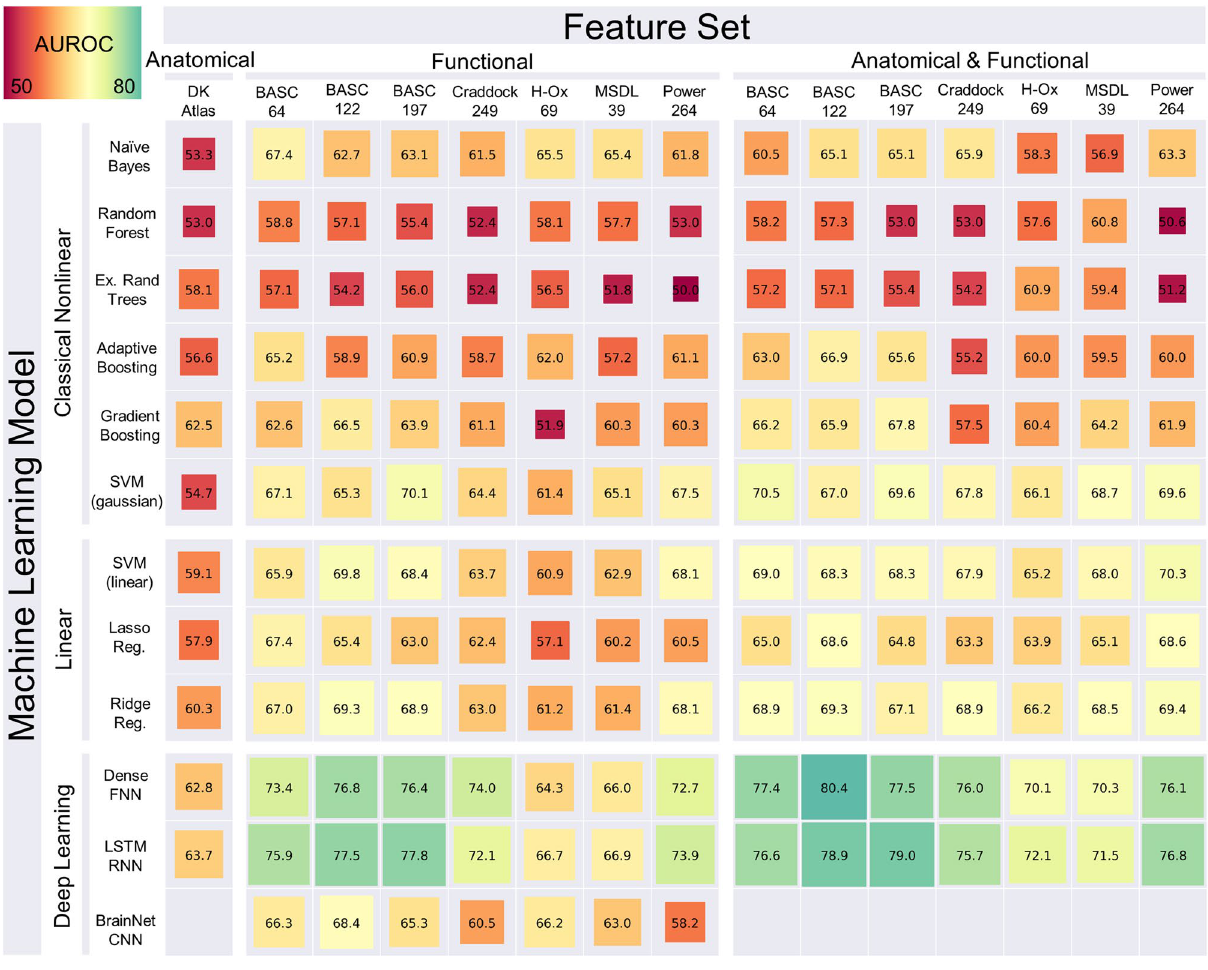
Figure 1. Performance of classifiers predicting the diagnosis of ASD versus TD. Performance is measured as the area under the ROC curve (AUROC) on held-out test data from IMPAC. Greener colors and larger boxes indicate higher performance. Note that BrainNetCNN can only be applied to fMRI data. Rows indicate the type of machine learning model used while columns indicate the feature set (volumetry, connectivity based on a brain-atlas parcellation, or both) and the atlas parcellation name. Models were further broken into linear, nonlinear, and deep learning methods. Features were grouped into anatomical, functional, and combined anatomical and functional features. See “Methods” for further detail. DK Desikan–Killiany atlas, Ex. Rand Trees extremely random trees, SVM ( Gaussian ) support vector machine with a Gaussian kernel, SVM ( linear ) SVM with linear kernel, lasso reg. logistic regression with L1 penalization, ridge reg . logistic regression with L2 regularization, Dense FNN dense feedforward neural network, LSTM RNN bidirectional long short term